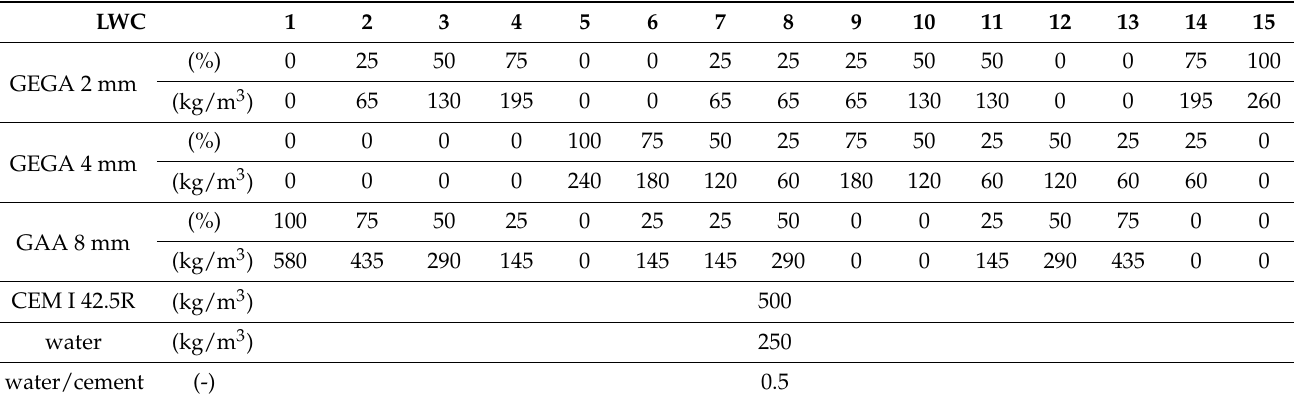
Table 2. Details of LWC mix proportions.